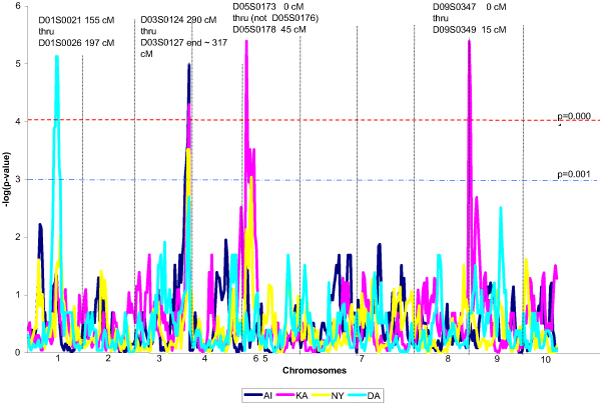
Raw nonparametric linkage multipoint results. The red dashed line represents the 0.05 genome-wide significance level adjusted for multiple tests (Bonferroni adjustment). The other blue line indicates the unadjusted p-value of 0.001.